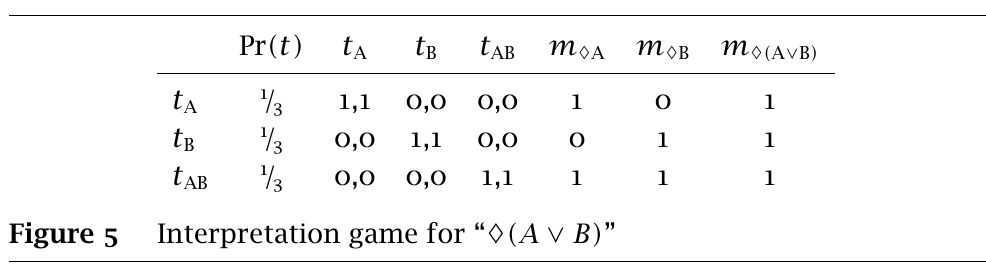
Figure 5 Interpretation game for “ ♦ (A ∨ B)